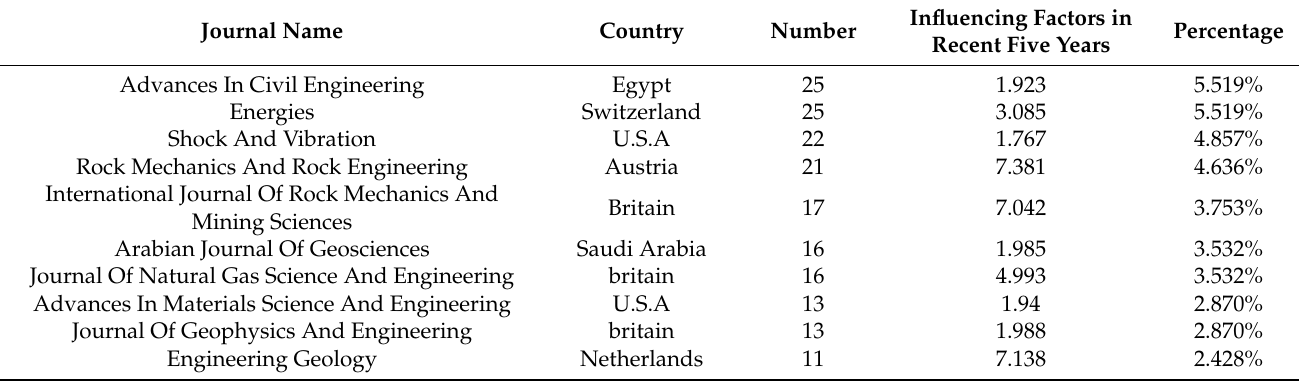
Table 8. Statistical table of the number of articles published by the top ten